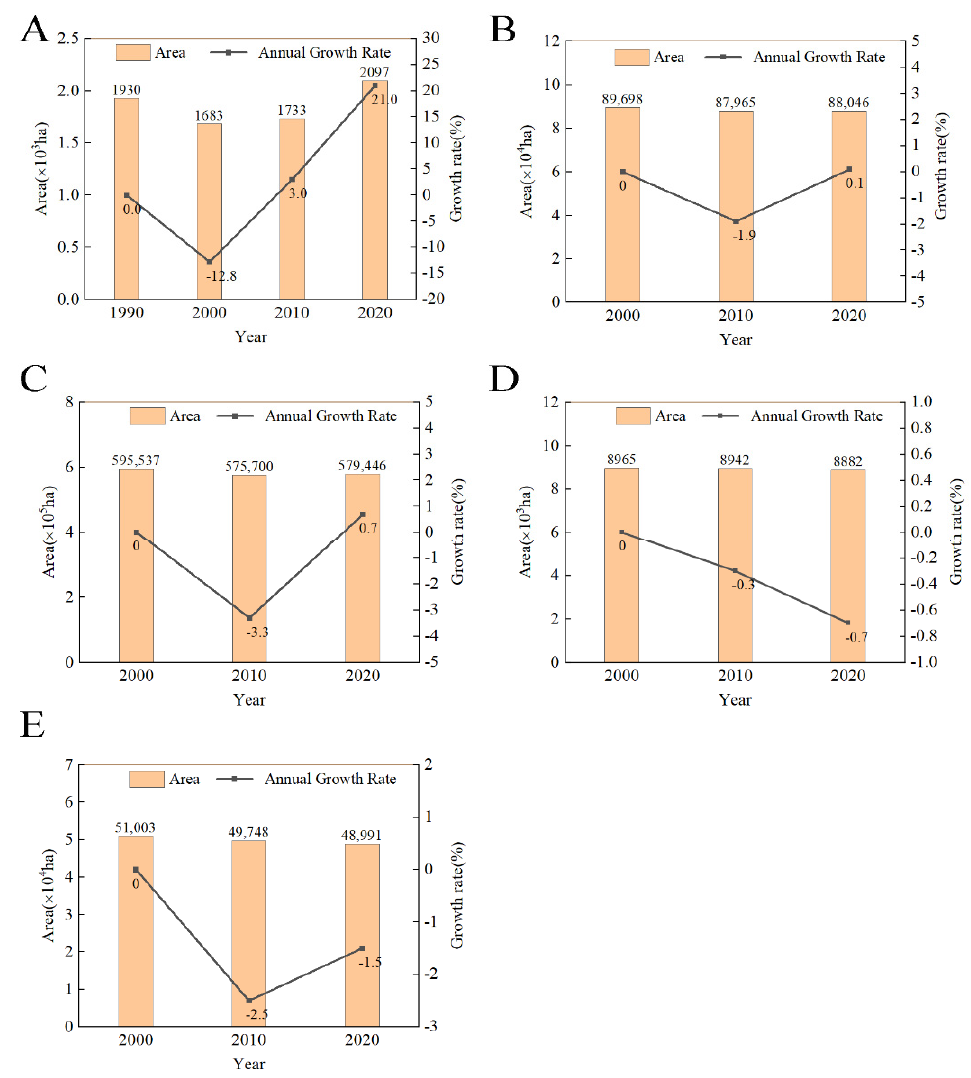
Figure 3. The dynamics of the mangrove habitats in five sites. ( A ): Dongzhaigang(1990 − 2020); ( B ): Sembilang NP; ( C ): Sundarban; ( D ): Kakadu NP; ( E ): RUMAKI (2000 − 2020).